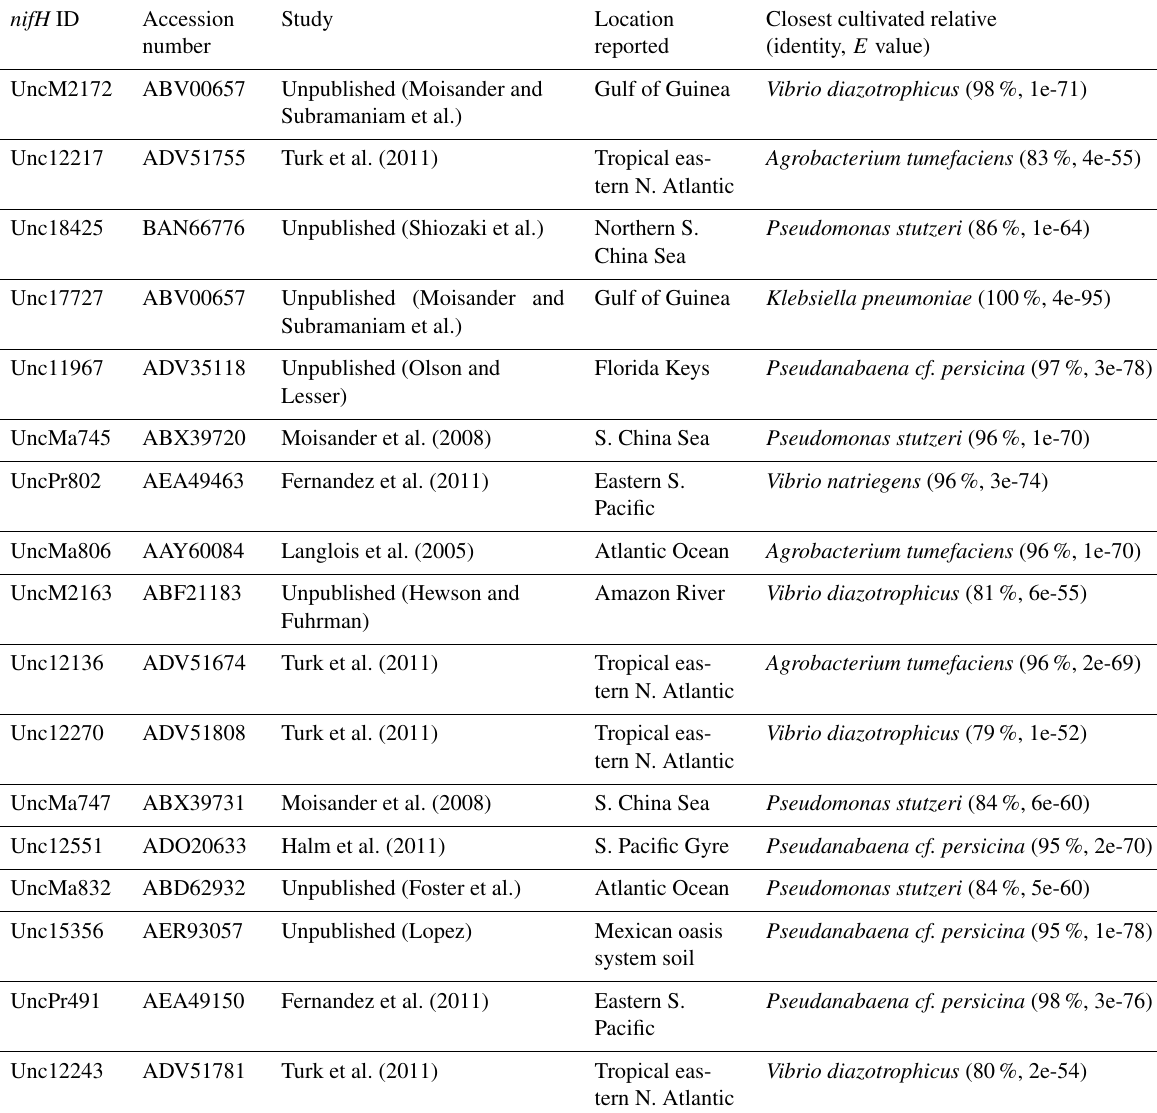
Table 1. Blastp identities to members of the 1G